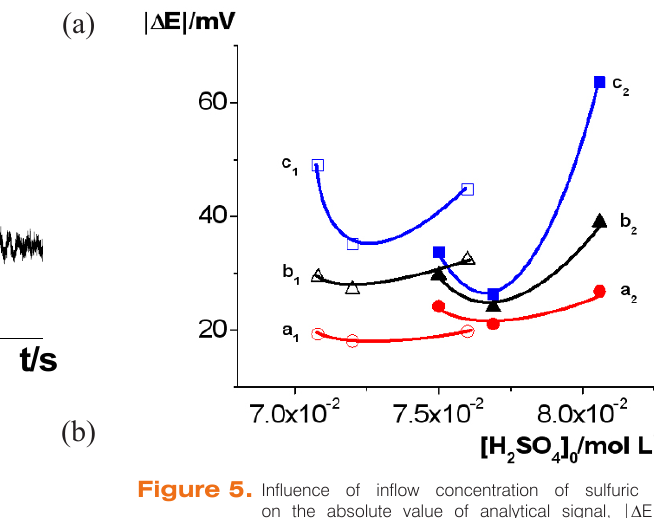
Figure 5. Influence of inflow concentration of sulfuric acid on the absolute value of analytical signal, | ∆ E| = |E − E |. The injected concentrations of PX are p s 255.1 µg mL −1 at temperatures 55.0°C (a